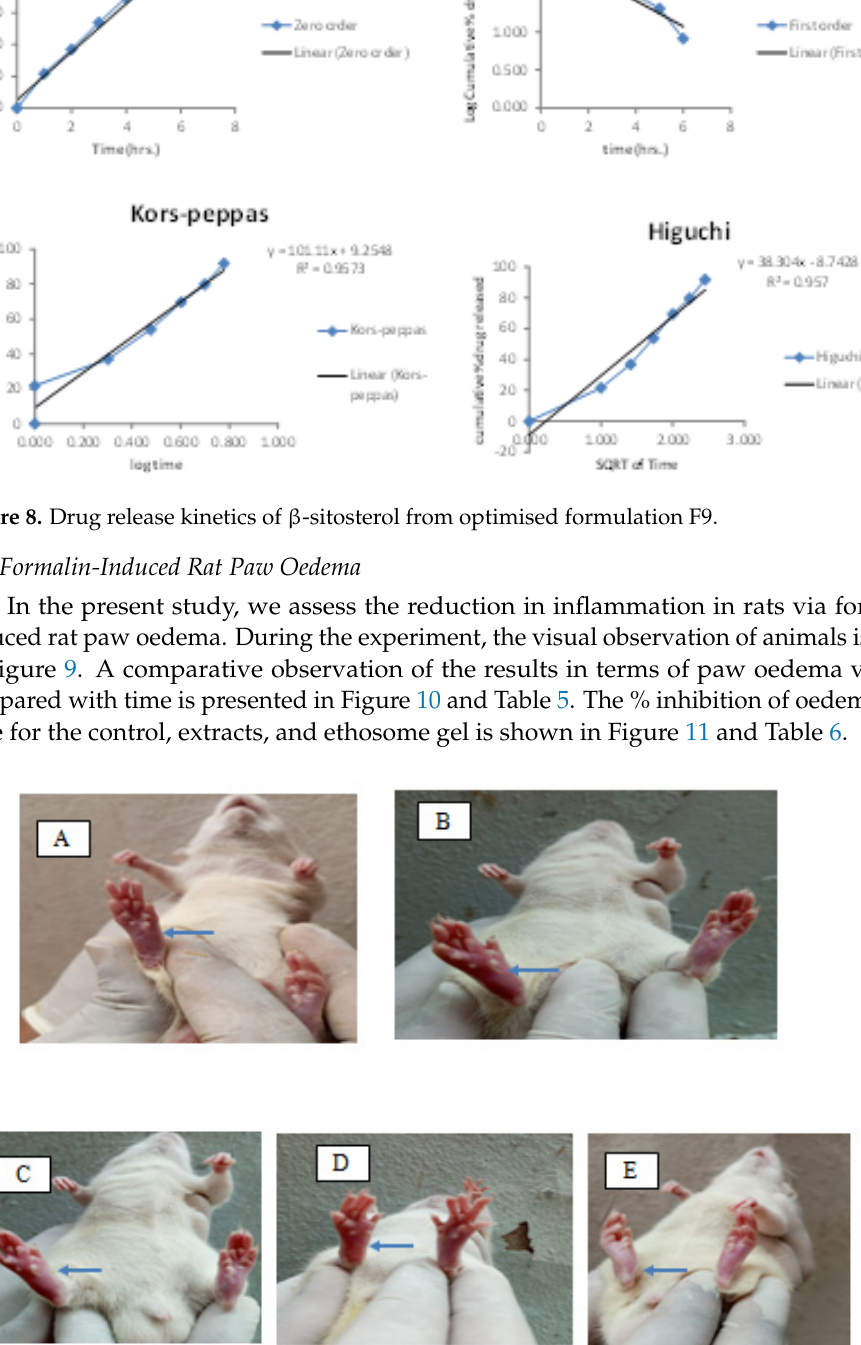
Figure 10. Inflammation volume observation in rats of ethosome suspension and gel. Table 5. Paw volume of different samples at different time intervals. Groups